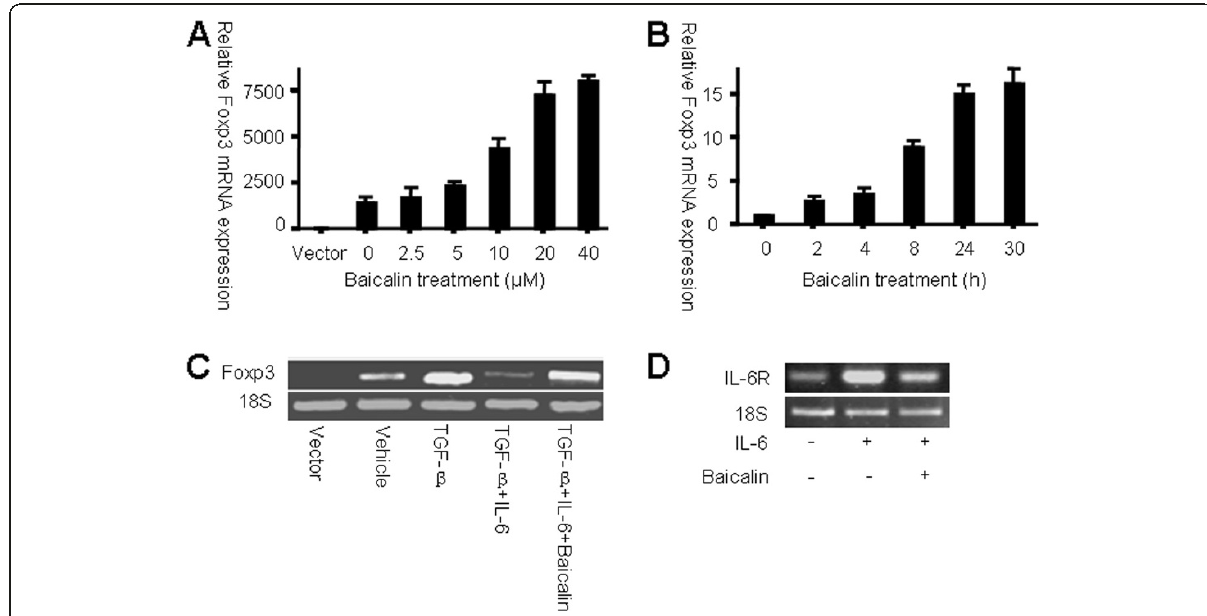
Figure 2 Baicalin up-regulates Foxp3 expression in HEK 293 T cells. Foxp3 mRNA levels in transfected HEK 293 T cells are shown ( A ) Twenty-four hours after transfection, cells were treated with Baicalin for another 24 h. The dose-dependent induction of Foxp3 mRNA expression is shown. Date are expressed as mean±SD and compared with the vector control (expression level of the vector control was set as 1.0). ( B ) After transfection with Foxp3 expression plasmids, a second group of cells was treated with 20 μ M Baicalin. The time-dependent induction of Foxp3 mRNA expression is shown. Data are expressed as mean±SD (expression level at 0 h was set as 1.0). ( C ) Transfected HEK 293 T cells were treated with indicated cytokines in the presence or absence of Baicalin for another 24 h. Foxp3 mRNA was examined by